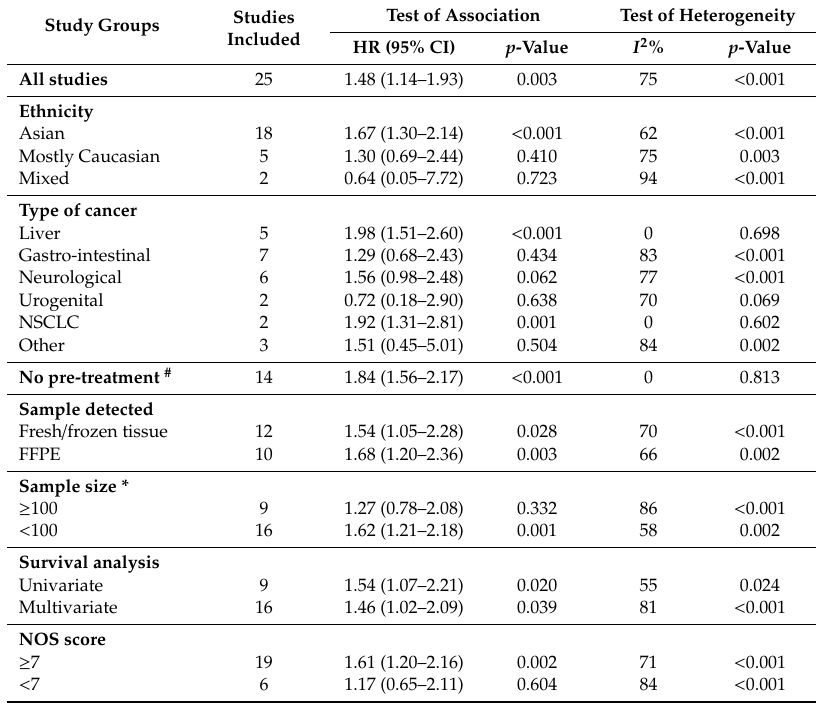
Table 3. Summary of random e ff ect meta-analyses for the association between miR-221 overexpression and overall survival of cancer patients.